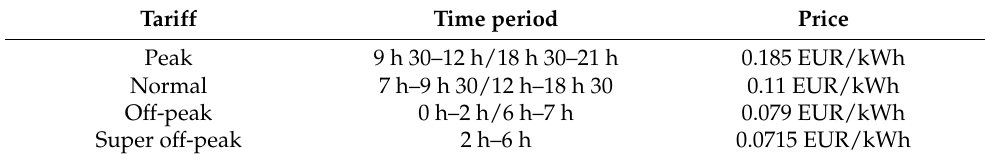
Table 1. Energy tariffs and prices for Portugal.